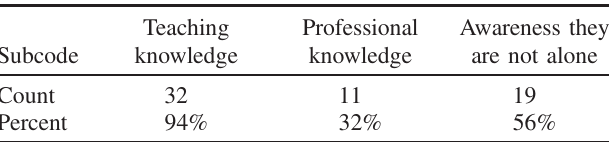
TABLE VI. The subcodes of the impact “ gained knowledge. ” People could fall into more than one category. Count represents the number of participants coded to a category. Percentages are out of 34